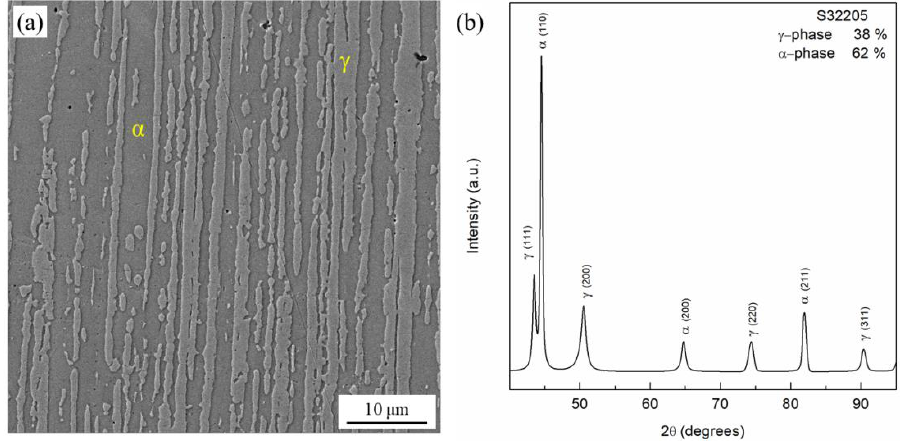
Figure 1. Microstructural characterization of as-received UNS S32205 reinforcement: ( a ) micrograph of the rolling direction × 50, and ( b ) XRD pattern and alloy phase fraction ( γ –phase and α